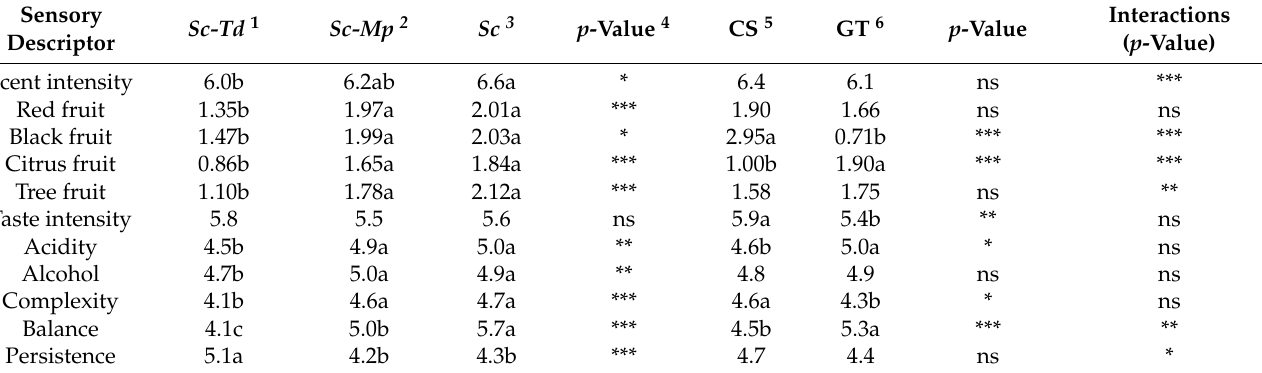
Table 2. Two-way analysis of variance (ANOVA) performed on the sensory scores of the ros é wines from different fermentation strategies and grape